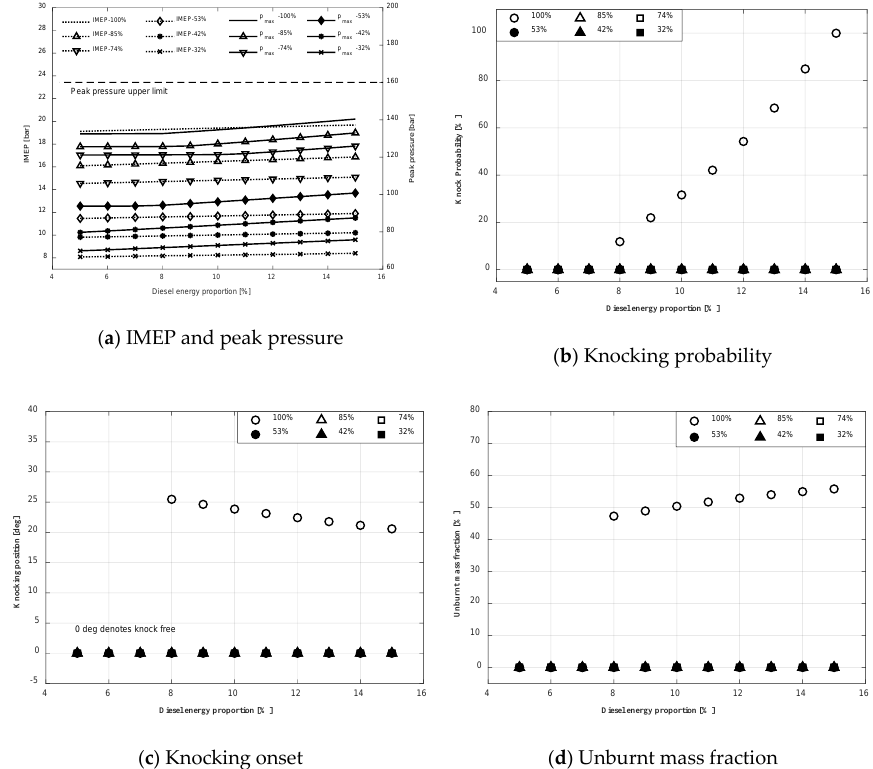
Figure 11. Pilot fuel energy proportion effect on engine performance and knocking parameters (Engine B).